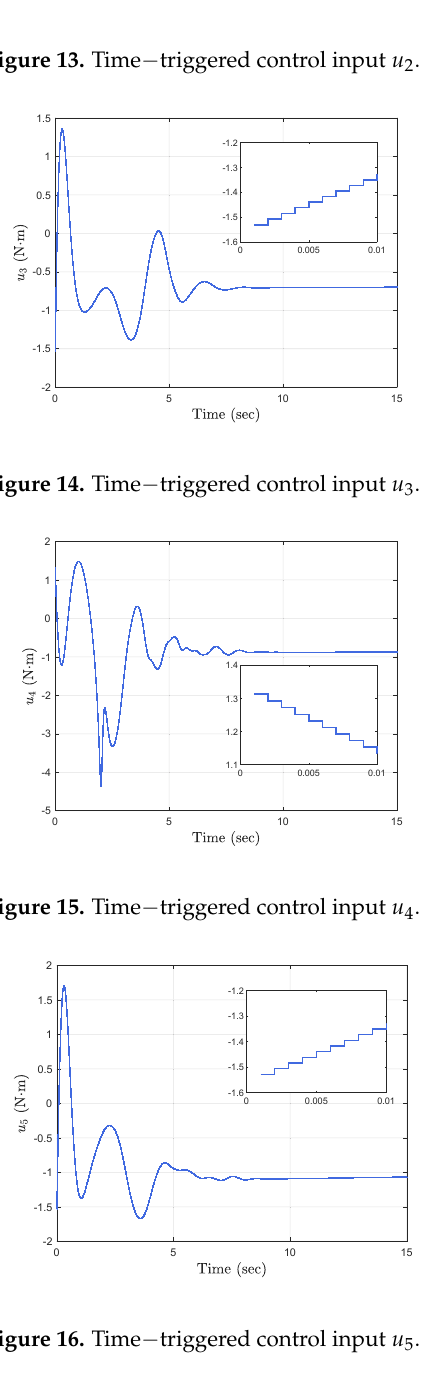
Figure 16. Time − triggered control input u 5